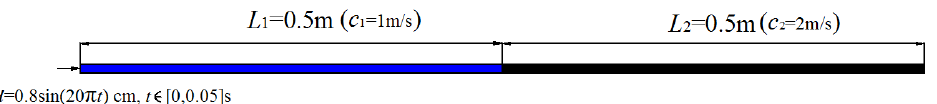
Figure 7. The scalar wave propagation along a one-dimensional elastic bar with different media.